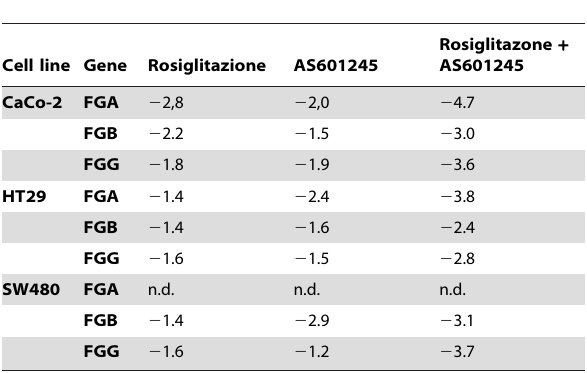
Table 7. Expression of fibrinogen chains detected by quantitative Real Time